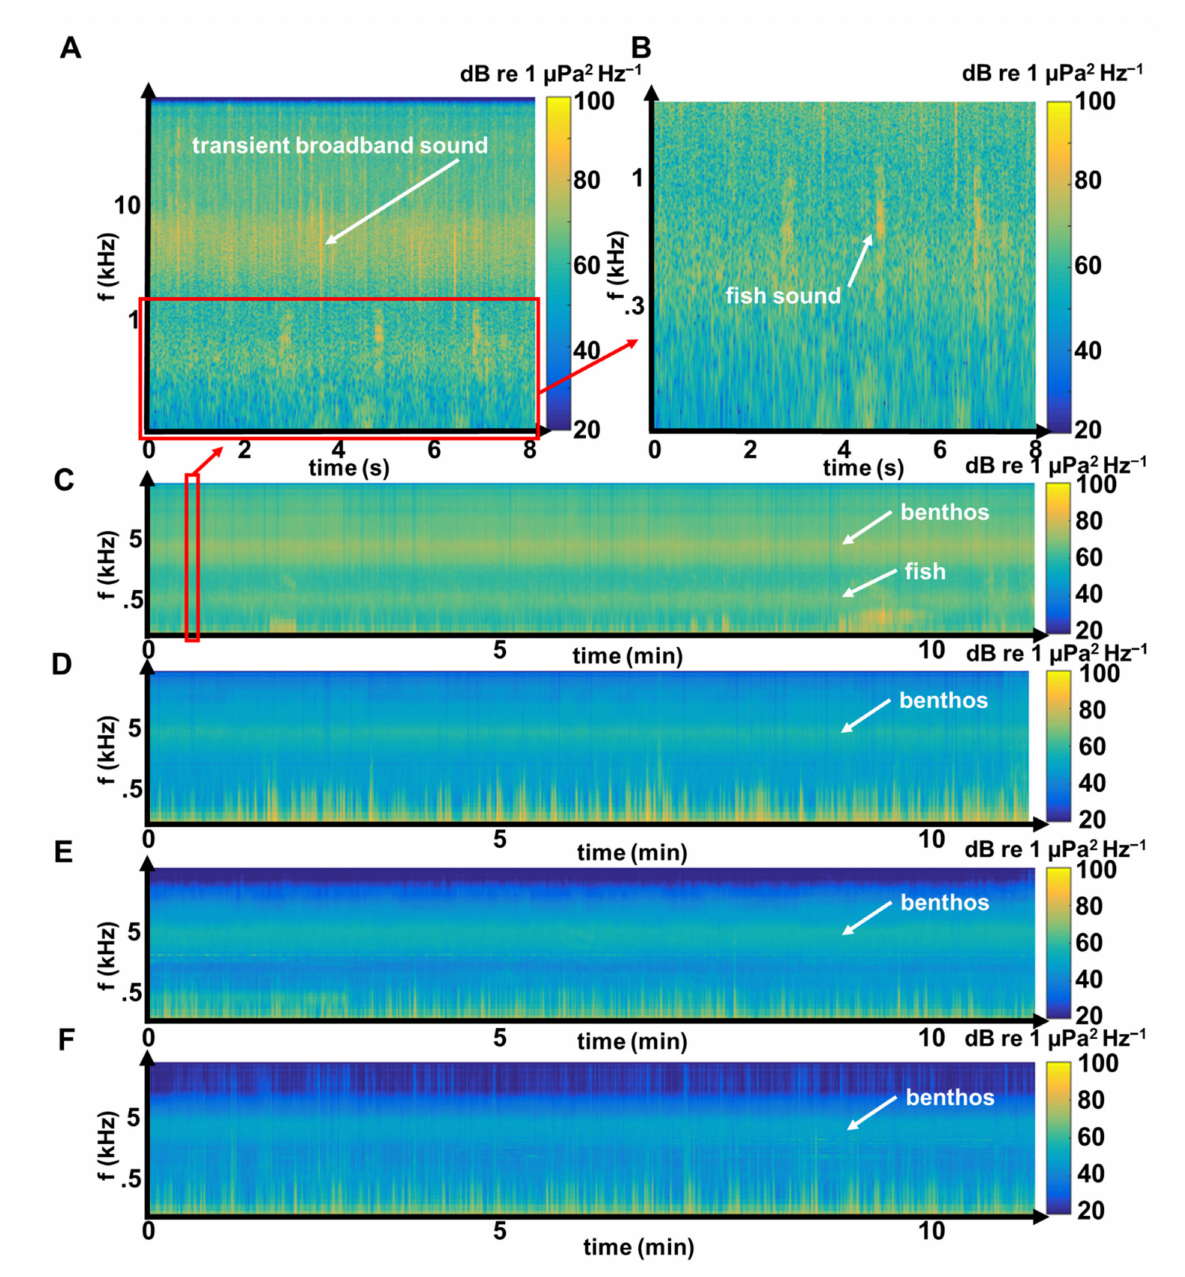
Figure 3. Spectrograms of the soundscapes recorded at different distances from the reef. A and B illustrate subsections of spectrogram C highlighting invertebrate ( A ) and fish sounds ( B ). ( C ) was recorded at 138 ± 11 m from the reef, ( D ) 964 ± 138 m, ( E ) 3896 ± 3 m and ( F ) 9866 ± 43 m from the reef crest. For A and B: LFFT = 16,384, overlap = 75%, window = Kaiser. For C, D, E and F: LFFT = 65,536, overlap = 50%, window =